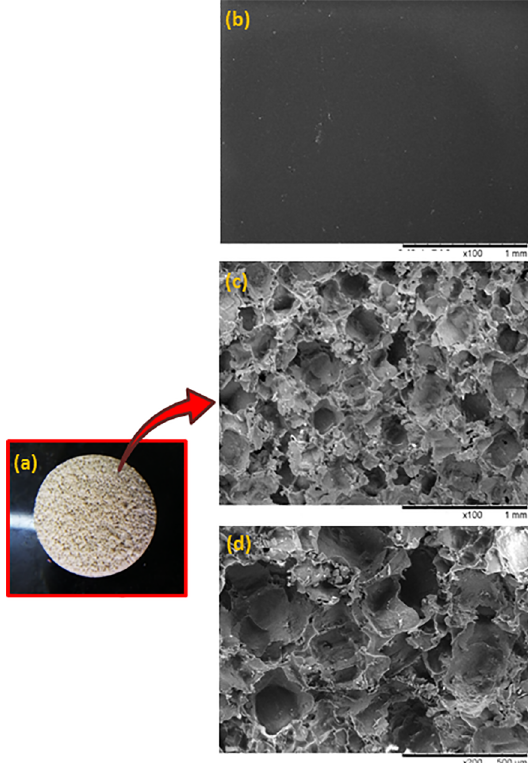
Figure 1. Micrographs of the porous surface of the sample without magnification (a), surface without pores with magnification of